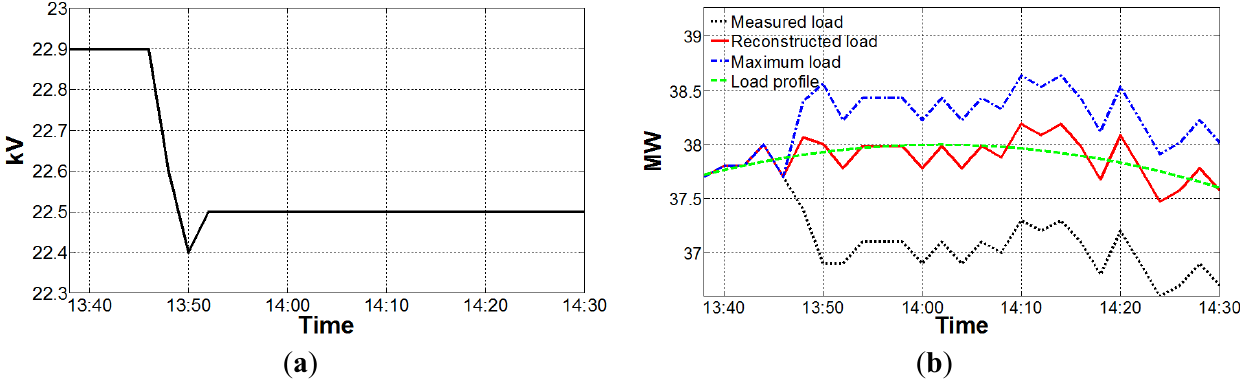
Figure 4. Results of the nationwide CVR implemented at the 705th transformer bank on 9 August 2012: ( a ) measured bank voltage; and ( b ) transformer-bank